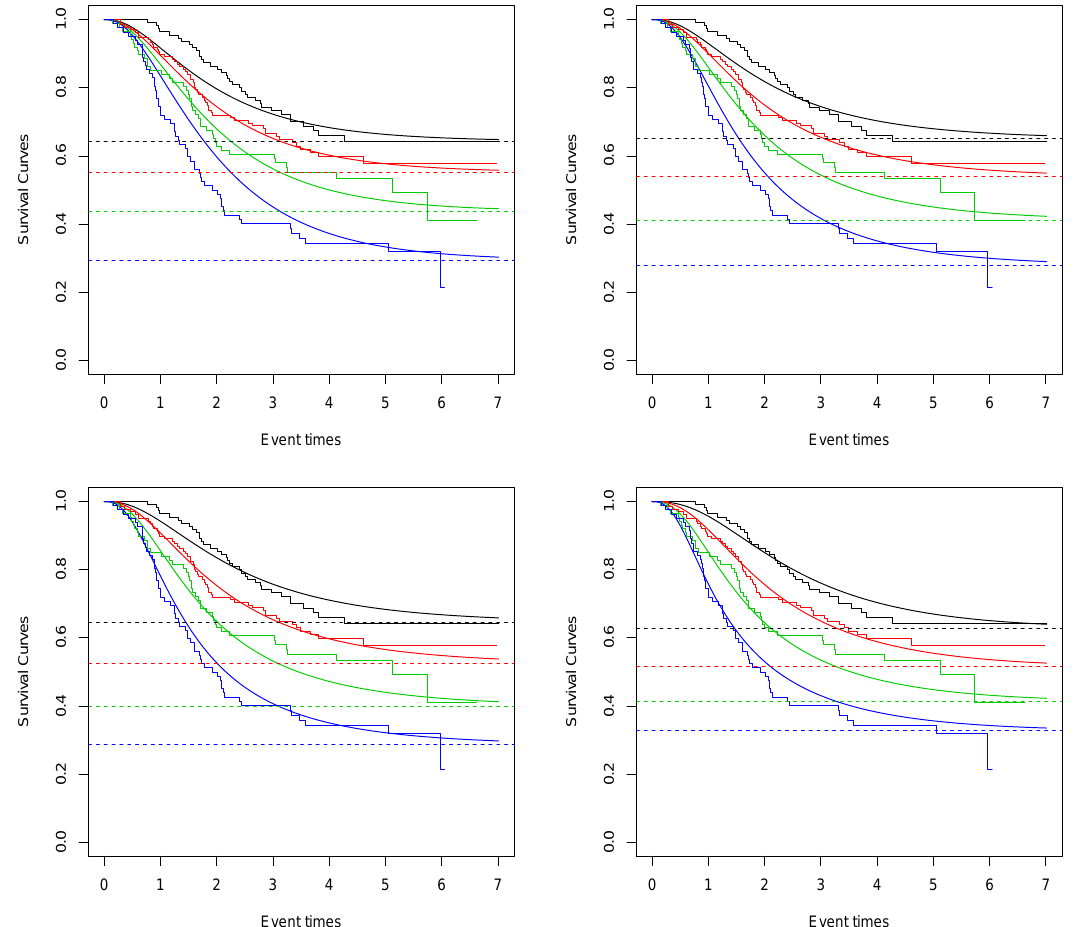
Figure 1. From the left to the right, top to bottom, the BerKumExp, PoiKumExp, GeoKumExp and NegBinKumExp distributions. The colors black, red, green and blue represent the nodule categories 1, 2, 3 and 4,